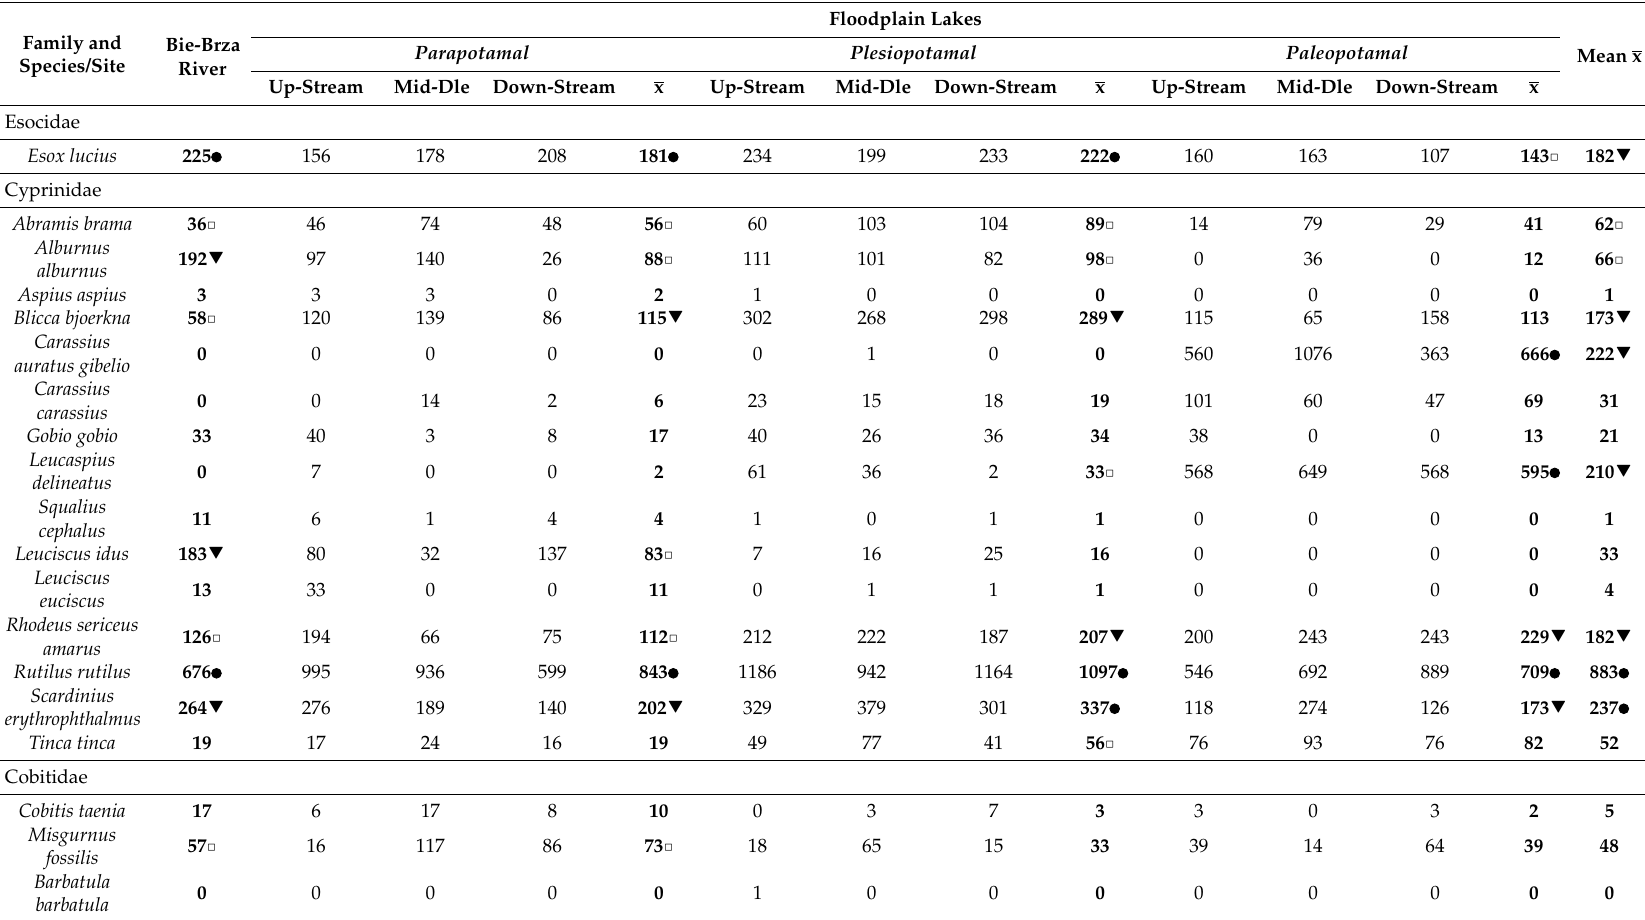
Table A1. Abundance of fish species in floodplain lake sites (specimens.ha ´ 1 ) in the floodplain lakes the Biebrza River in the period of 2011–2013. Dominance of İ species is based on sum of specimens: —eudominant; —dominant; subdominant; x